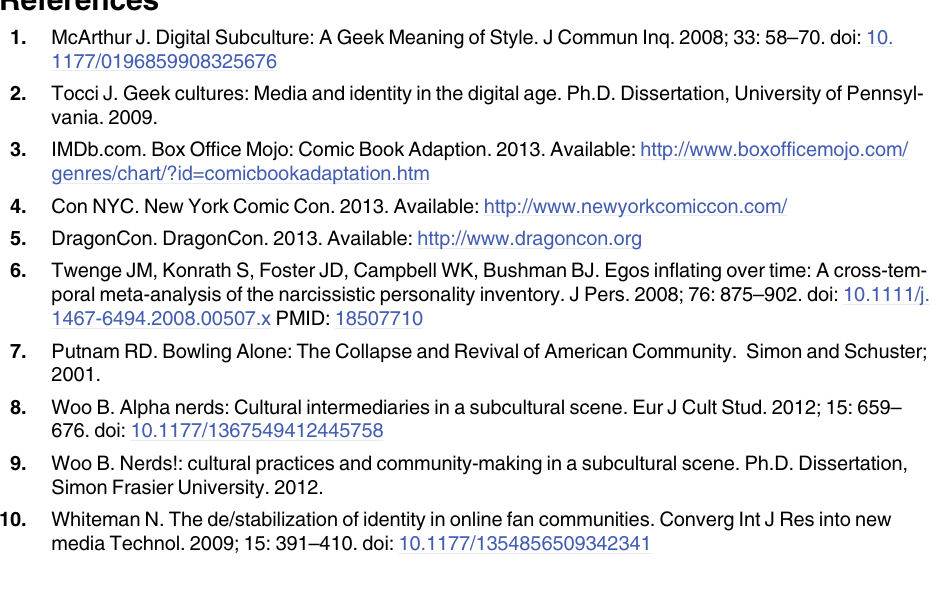
Strongly Strongly Disagree Agree